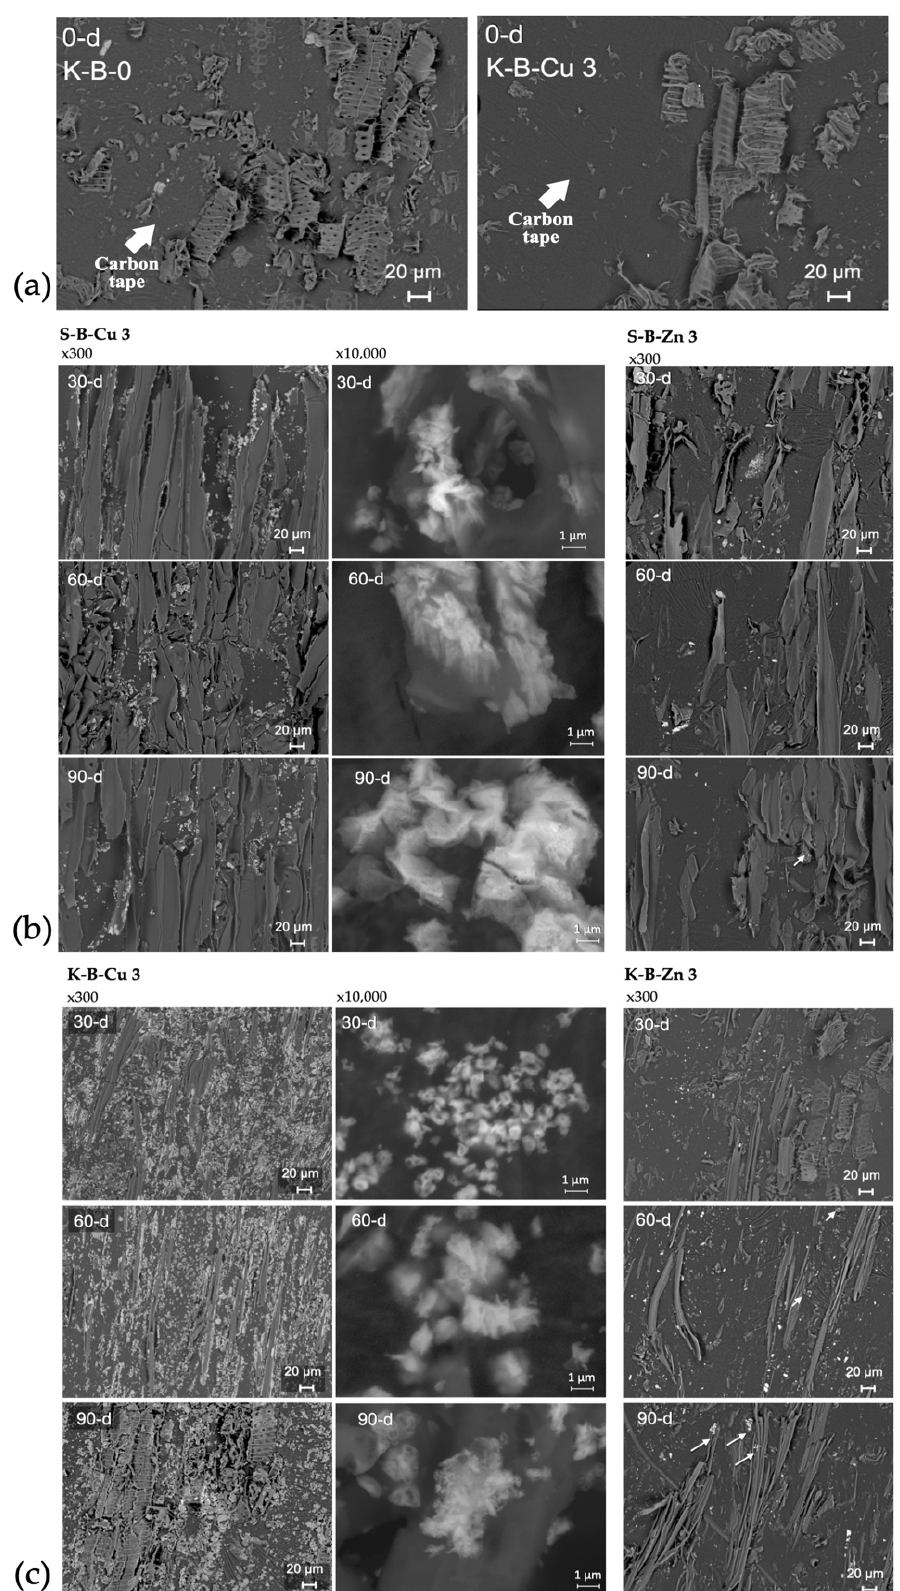
Figure 7. The SEM-BSE images of unexposed K-B-0/K-B-Cu 3 ( a ), exposed S-B-Cu 3 (300× and 1000×), S-B-Zn 3 (300×) ( b ), exposed K-B-Cu 3 (300× and 1000×) and K-B-Zn 3 (300×) ( c ). The white arrows point to the scattered particles among wood tissues in the samples with Zn contents.